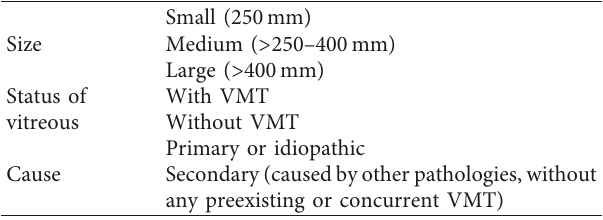
Table 1: The International Vitreomacular Traction Study (IVTS) Group classification of macular hole